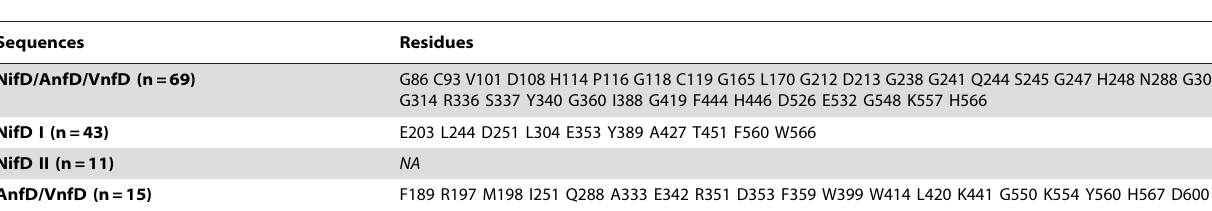
Table 5. Patterns of covariant residues in the